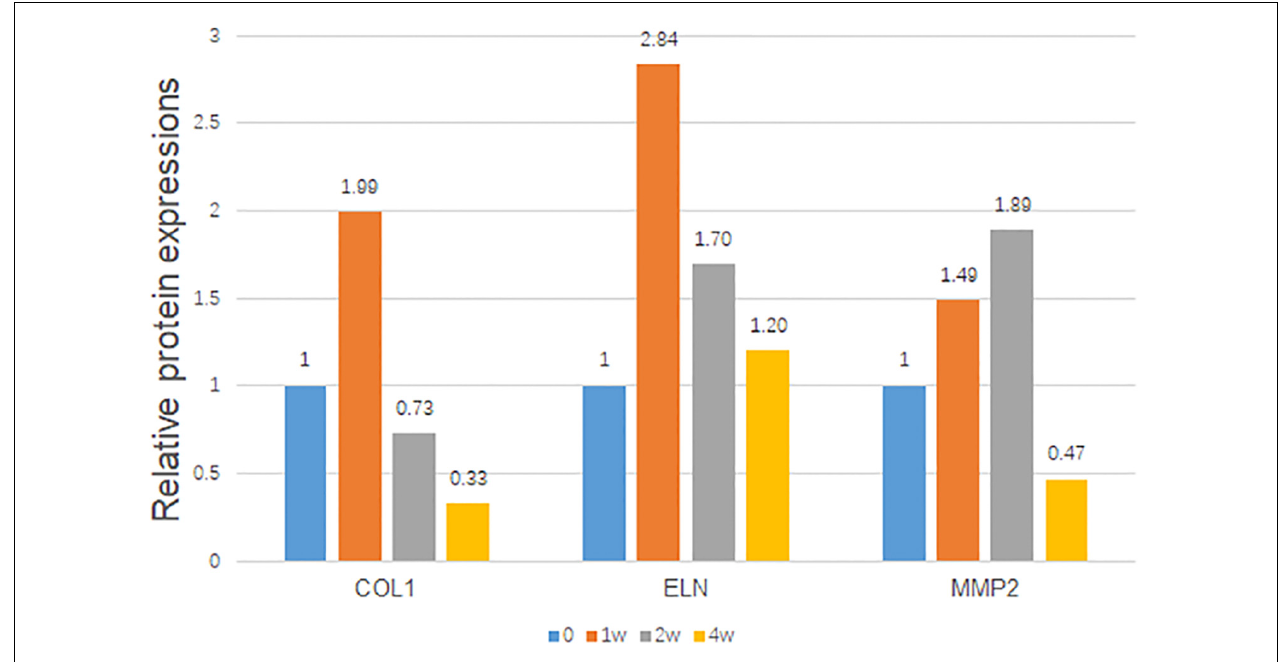
FIGURE 5 | Trends of the relative scleral protein expressions with time. The protein/GAPDH values of the hypertensive right eyes to the contralateral left eyes were demonstrated with time. GAPDH was set as the loading